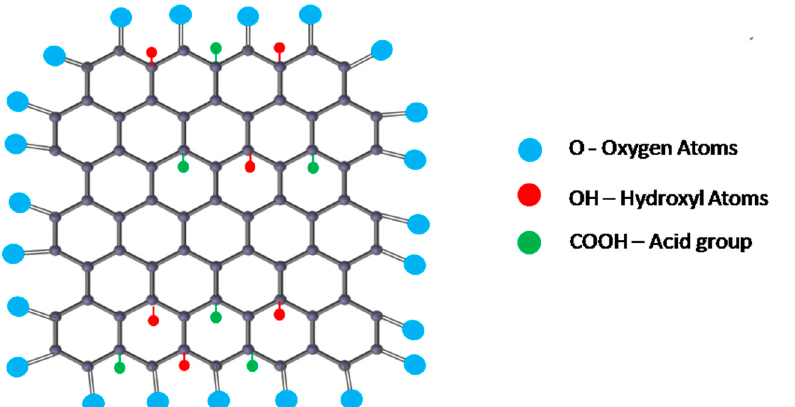
Figure 3. Acid-treated graphene nanoplatelets.